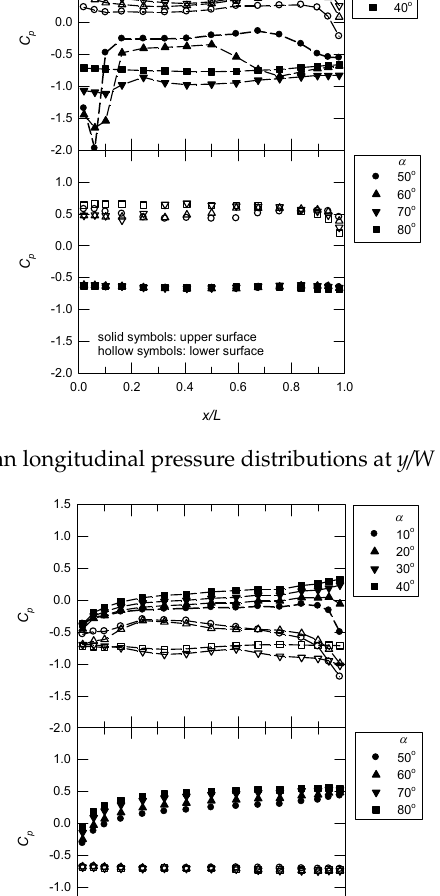
solid symbols: upper surface hollow symbols: lower surface